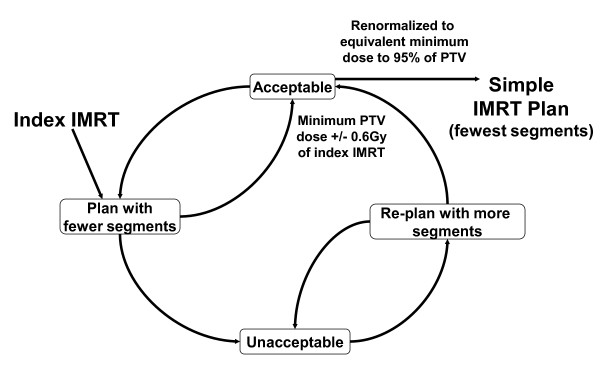
Schematic of Intensity Modulated Radiotherapy Segment Number Reduction.